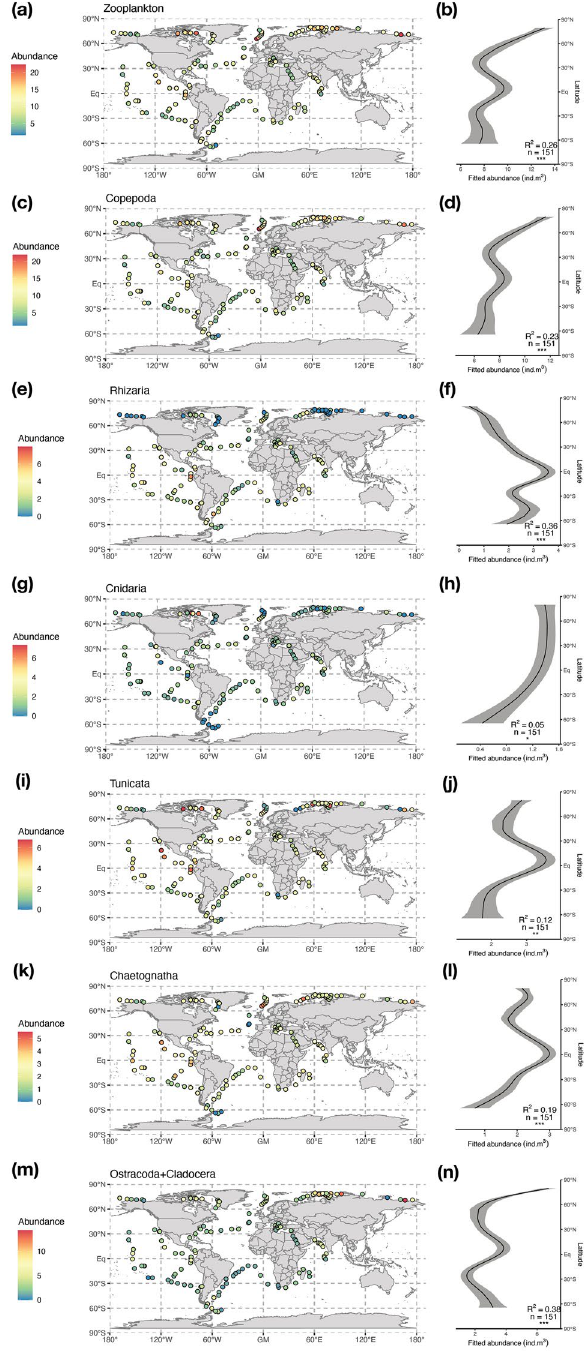
Figure 1. Maps and latitudinal patterns of the abundance (cubic-transformed ind m 3 ) of ( a , b ) Total zooplankton, ( c , d ) Copepoda, ( e , f ) Rhizaria, ( g , h ) Cnidaria, ( i , j ) Tunicata, ( k , l ) Chaetognatha, and ( m , n ) Ostracoda + Cladocera observed in samples collected by the WP2 net. The solid curves on the right-hand side plots illustrate the prediction from the Generalized Additive Model (GAM) fitting abundance against latitude. The explanatory power of the GAM (adjusted R 2 ), the number of samples used and the significance of the smooth term (p < 0.001 = ***, p < 0.01 = ***, p < 0.05 = *, p > 0.05 = ns) are reported on the plots. The grey ribbon illustrates the standard error of the GAM